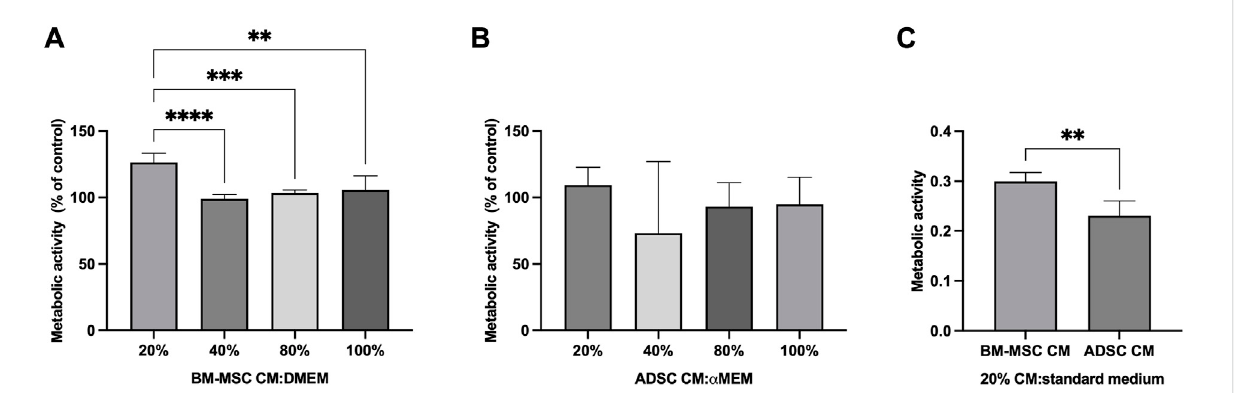
FIGURE 3 BM-MSC-derived secretome enhanced hNPC metabolic activity. MTT assay on hNPCs treated with BM-MSC-derived CM (A) or ADSC-derived CM (B) at a 20%, 40%, 80% or 100% concentration (percentage of CM diluted in DMEM, volume/volume) showed that 20% BM-MSC CM yielded the greatest effect towards cell metabolic activity. Data are expressed as percent variation between the control and experimental groups. (C) 20% BM-MSC-derived CM determined a signi fi cantly higher increase of metabolic activity in hNPCs compared to 20% ADSC-CM. ** p < 0.01, *** p < 0.001, **** p <